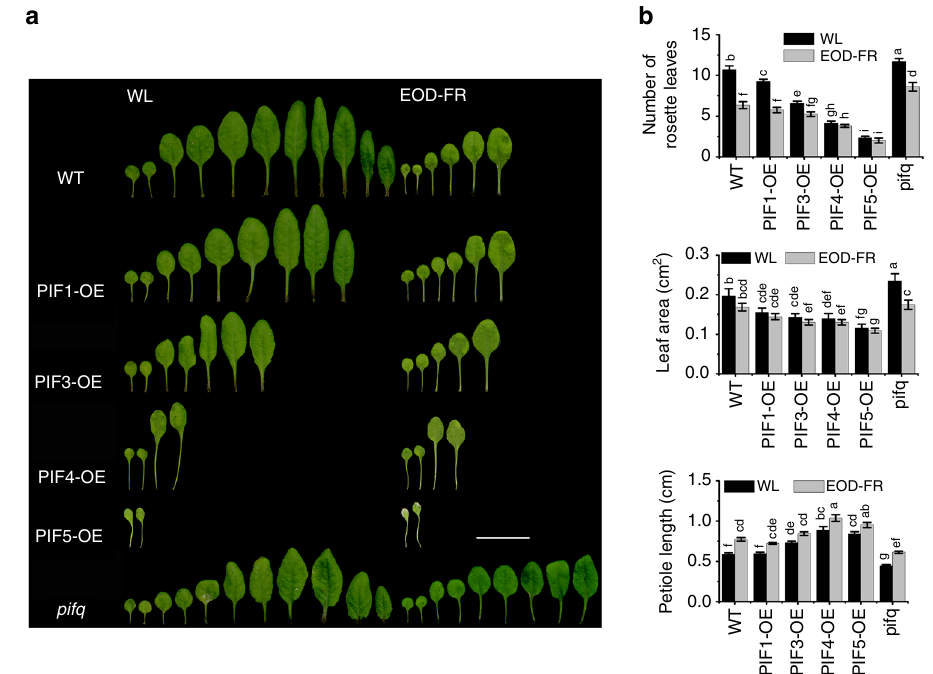
Fig. 1 Adult PIF overexpressors exhibit constitutive SAS under normal high R:FR conditions and attenuated SAS responses under simulated shade conditions. a Comparison of the rosette leaf number, leaf blade area, and petiole length of the fi rst and second leaf between PIF overexpressors, pifq , and WT plants grown under normal high R:FR (WL) or simulated shade (EOD-FR) conditions. Eight-day-old seedlings were moved into the soil and grown under WL with or without EOD-FR treatment for 4 weeks. Bar = 2 cm. b Quanti fi cation of the rosette leaf number, leaf blade area, and petiole length of PIF ovexpressors, pifq , and WT under WL or EOD-FR conditions. Values shown are mean ± SD ( n = 12). Different letters indicate signi fi cant differences by